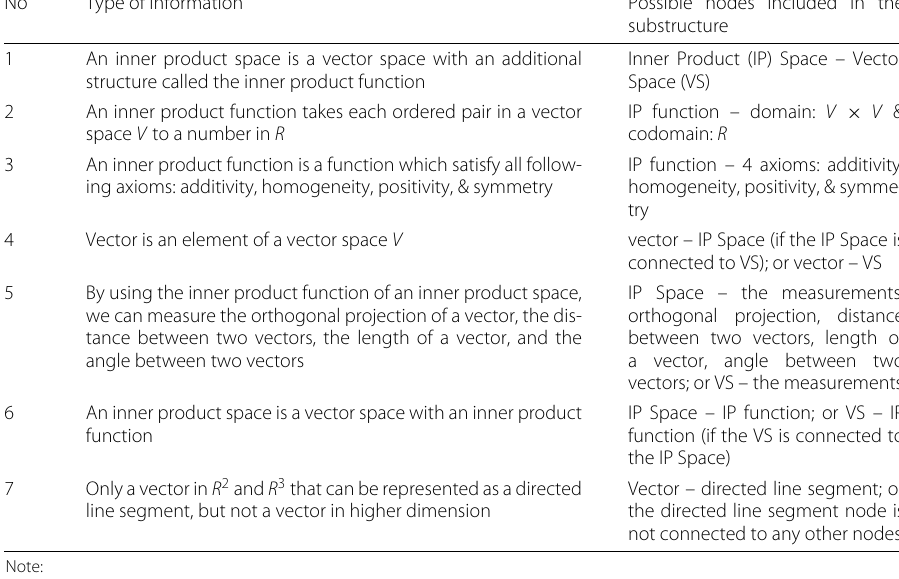
Table 1 Seven essential pieces of information included in the map and its possible substructure No Type of information Possible nodes included in the